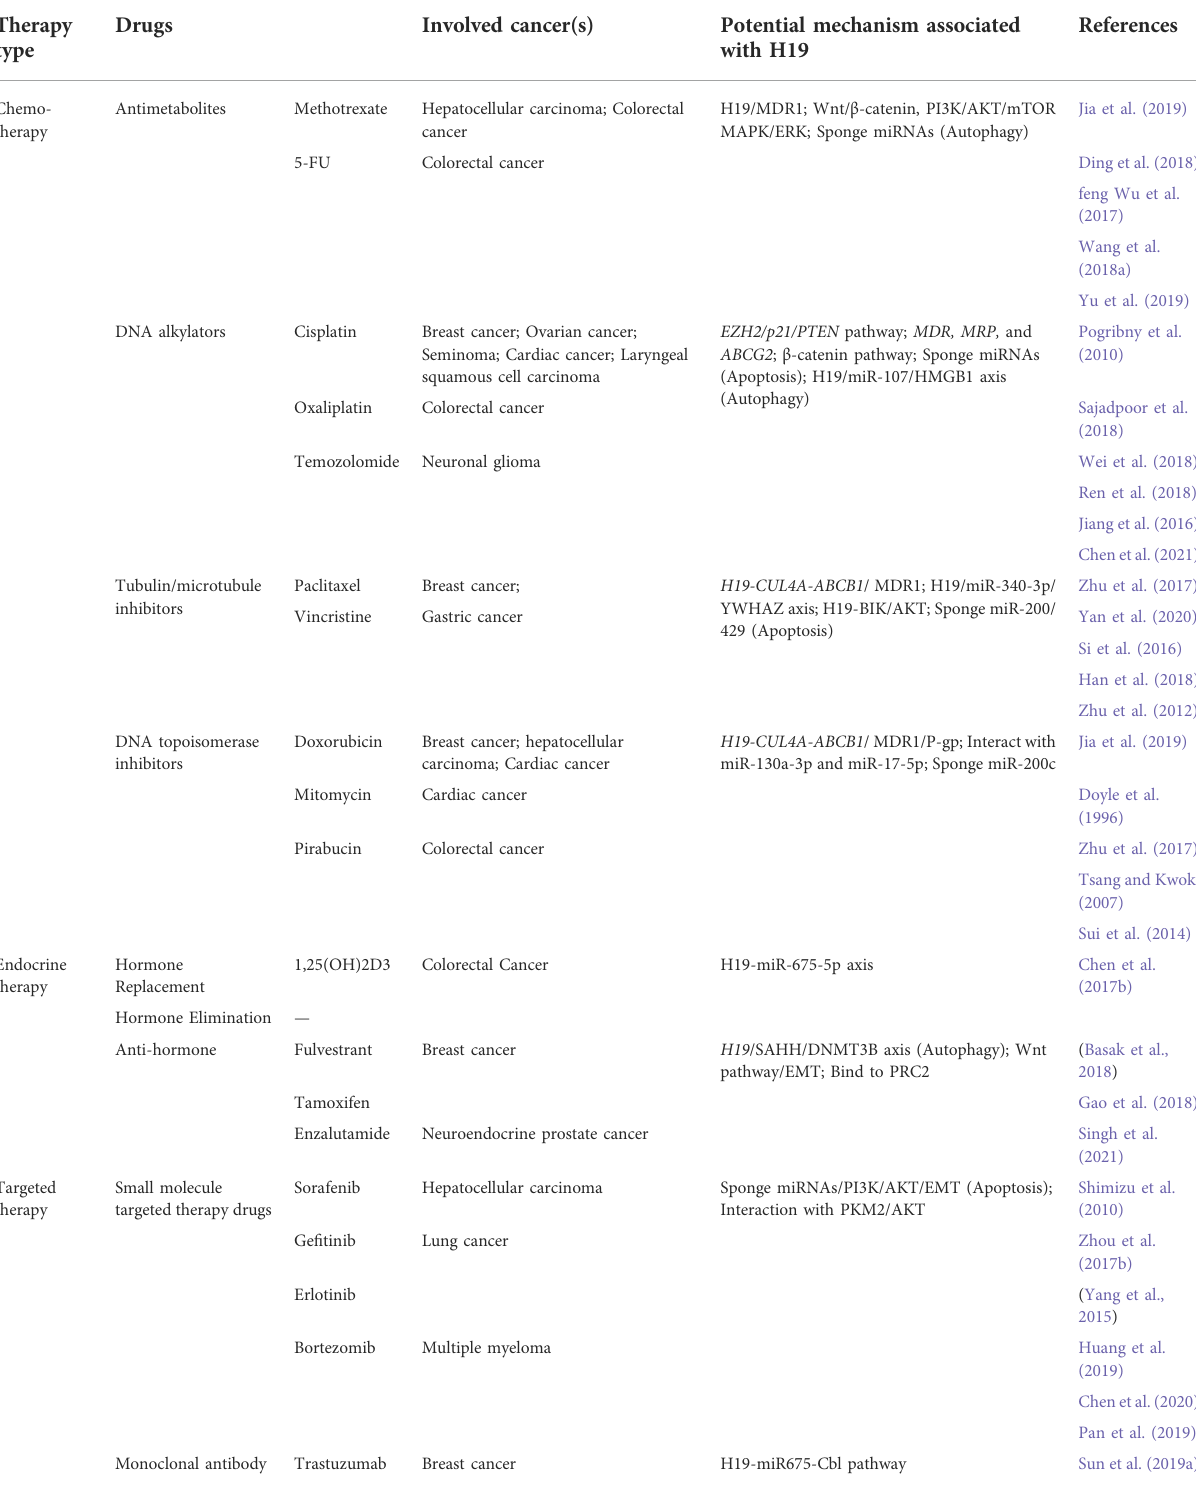
TABLE 2 Summary of different resistant drugs to human cancers via